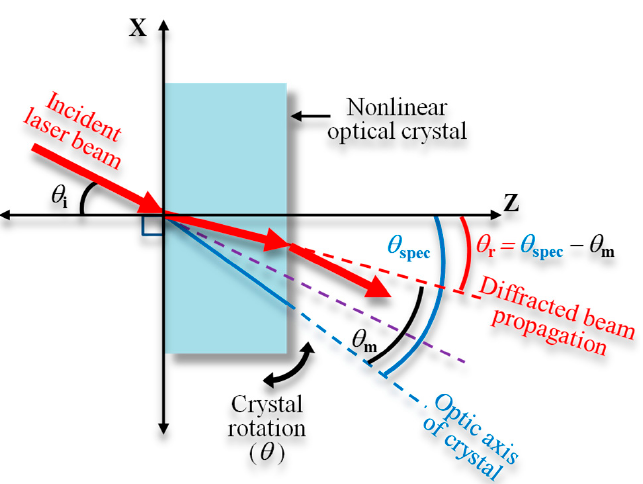
Figure 4. Schematic of refraction effect due to crystal diffraction; the change in direction of an incident laser beam through a nonlinear optical crystal.